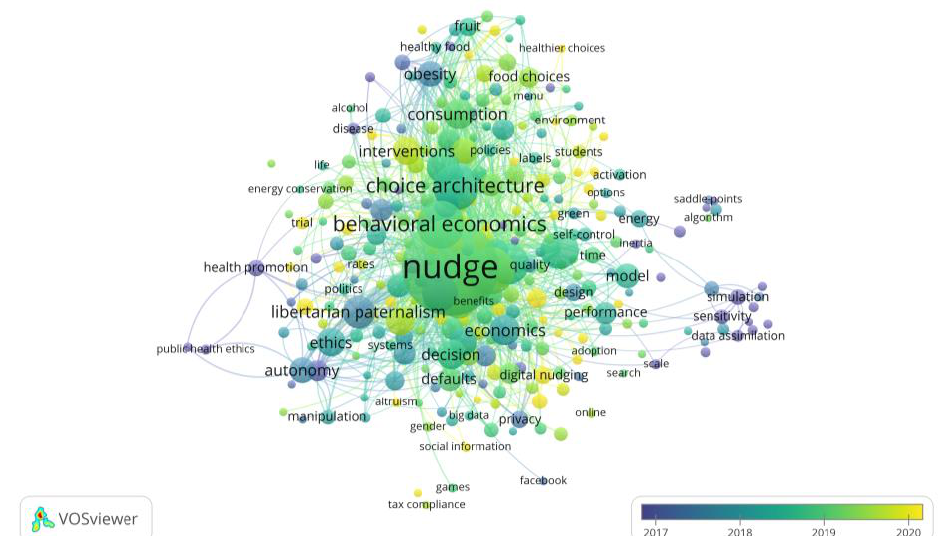
Figure 9. Overlay visualization of keyword co-occurrence analysis.